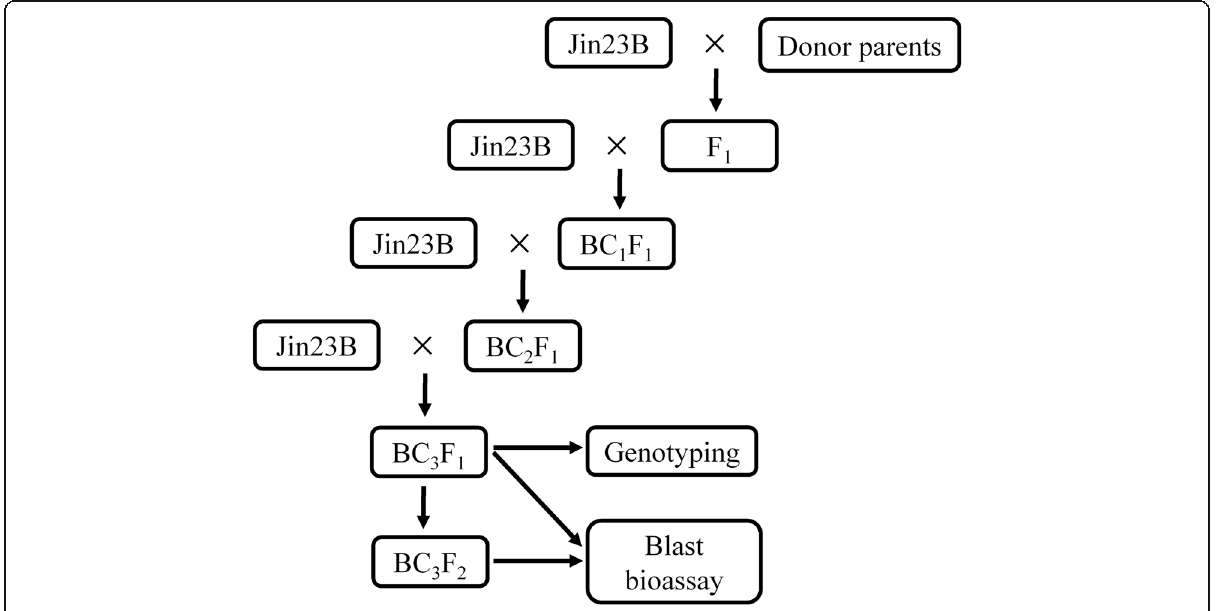
Fig. 1 Strategy to develop mapping populations for blast resistance